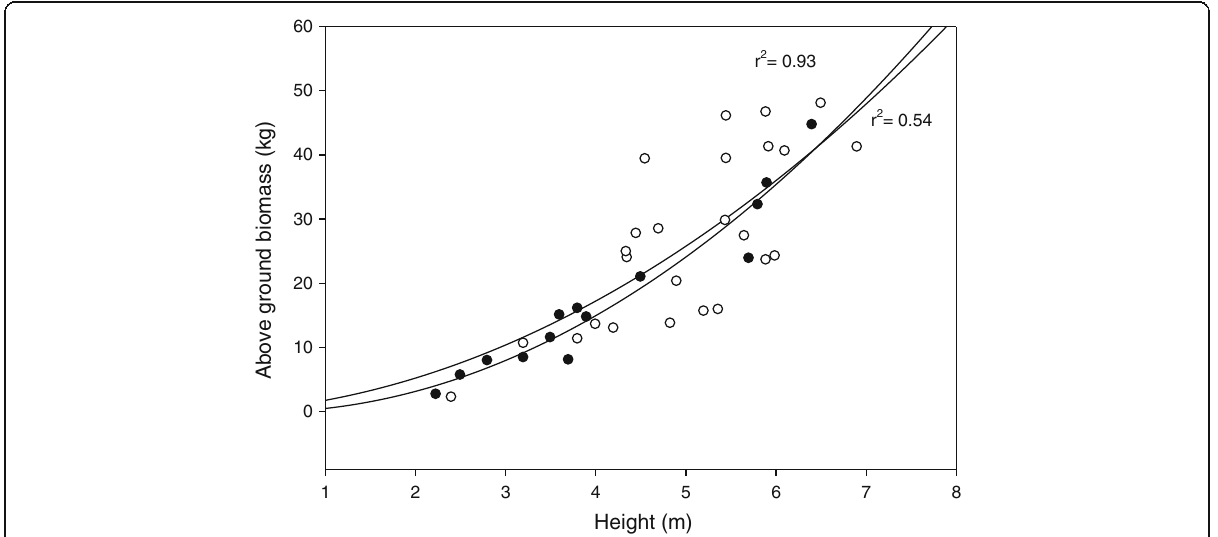
Fig. 3 Regression lines of total dry biomass (in kg) versus height (H) (open circles) for Juniperus procera and (filled circles) for Acacia